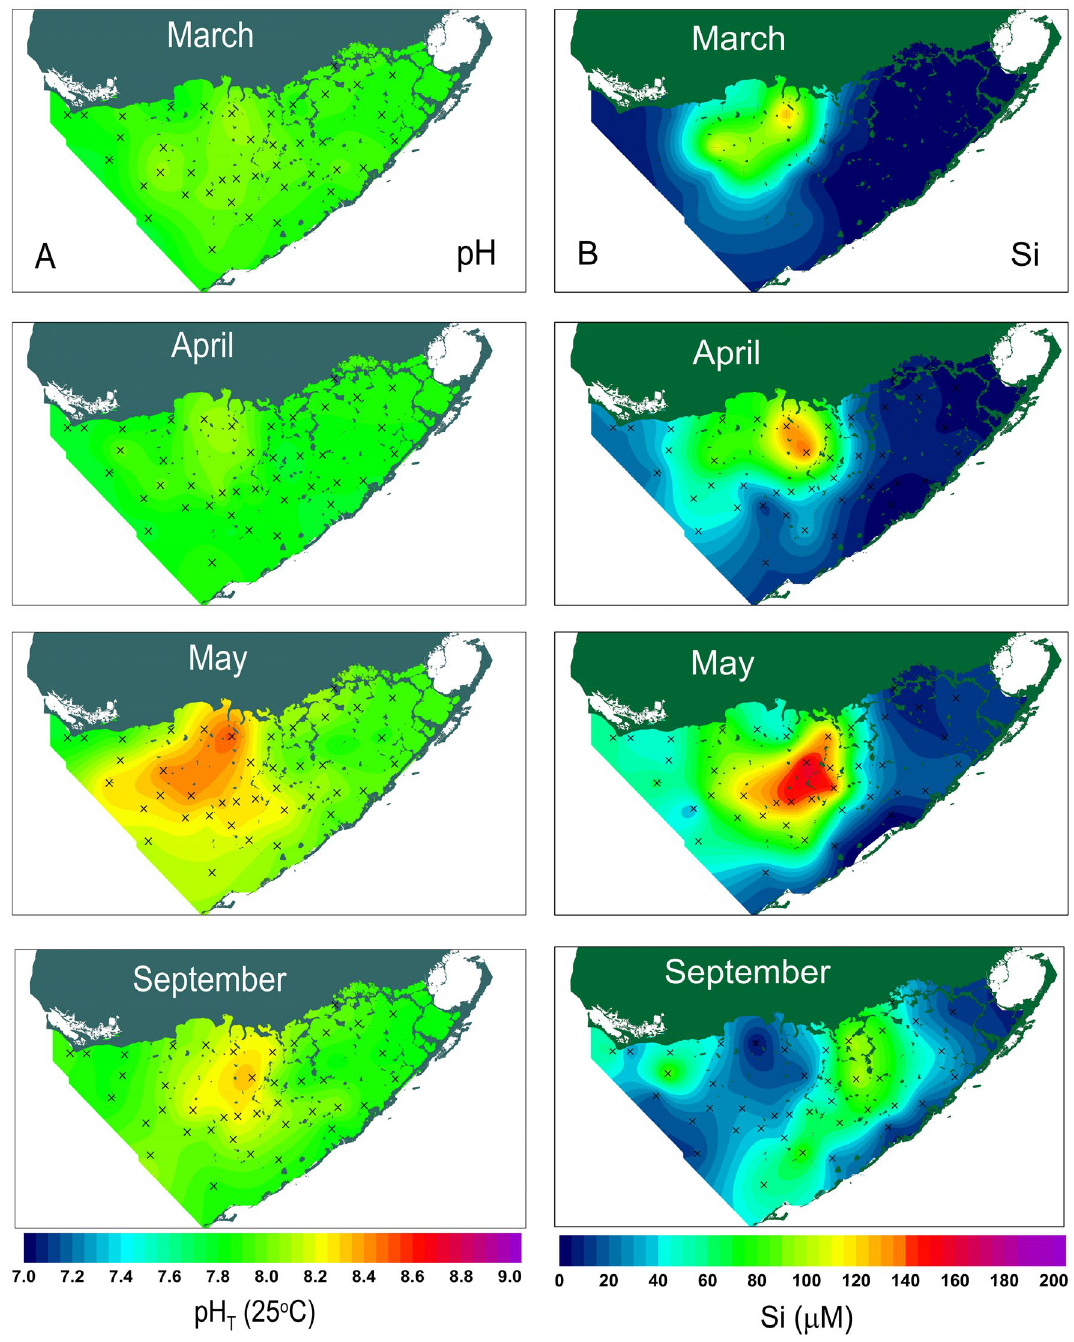
Figure 3. Seasonal changes in spatial distribution of ( A ) pH (7.0–9.0, interval 0.2) and ( B ) dissolved silicon (Si, 0–200 µM, interval 20 µM) in Florida Bay waters during year 2011. The contour maps were generated using a commercial software Surfer version10 (https:// www. golde nsoft ware. pH was associated with maximum dissolved silicon and varied from 8.1 to 8.6. In spring, the maximum pH was 8.2 ± 0.1 and rapidly increased to 8.5 ± 0.1 in May. Maxima pH decreased gradually in fall and winter to 8.3 ± 0.1. Bay‑wide integrated monthly inventory of silica dissolution and calcium carbonate precipi - tation and their interannual variation. The seasonal and interannual variation in the bay-wide dis- solved silicon inventory is shown in Fig. 5, which is similar to maximum dissolved silicon concentration because the inventory is dominated by high-dissolved silicon waters. Bay-wide dissolved silicon inventory varied from 1.0 × 10 7 to 2.0 × 10 8 mol with an average of 1.0 × 10 8 ± 1.25 × 10 7 mol over the 1999–2012 period. The minimum bay-wide dissolved silicon inventory of 1.0 × 10 7 mol was observed in winter of 1999–2005. The winter minima increased to above 7.0 × 10 7 mol during 2006 and 2007. It decreased to 1.0 × 10 7 mol in 2010 but increased again